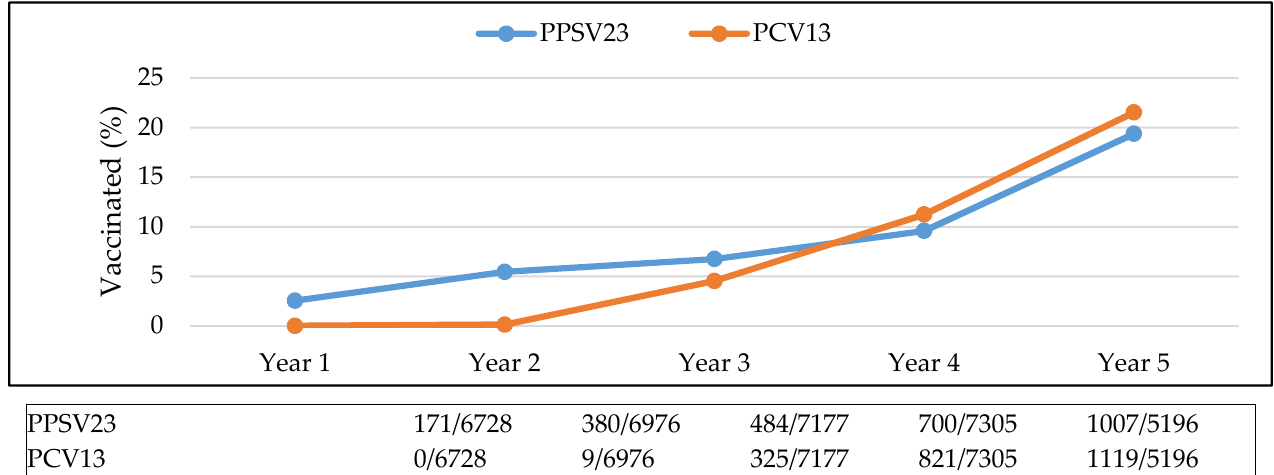
Figure 4. Percentage of population vaccinated, by vaccine. Abbreviations used: PPSV23: pneumococcal polysaccharide vaccine; PCV13: pneumococcal conjugate vaccine.